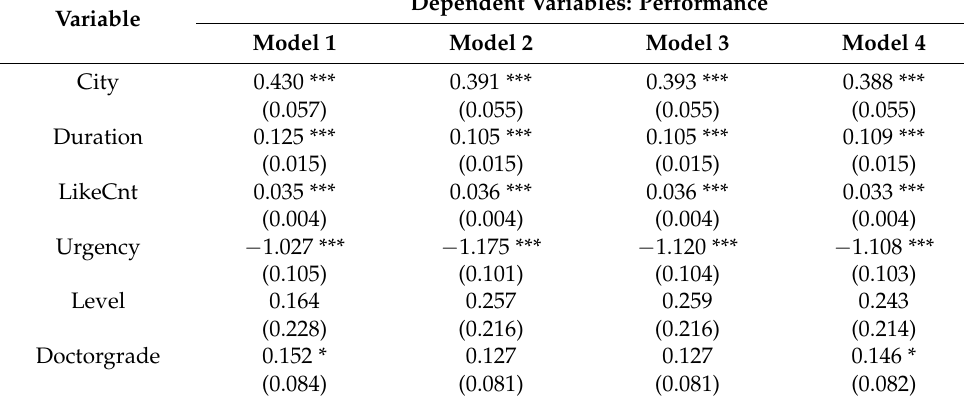
Table 6. Regression